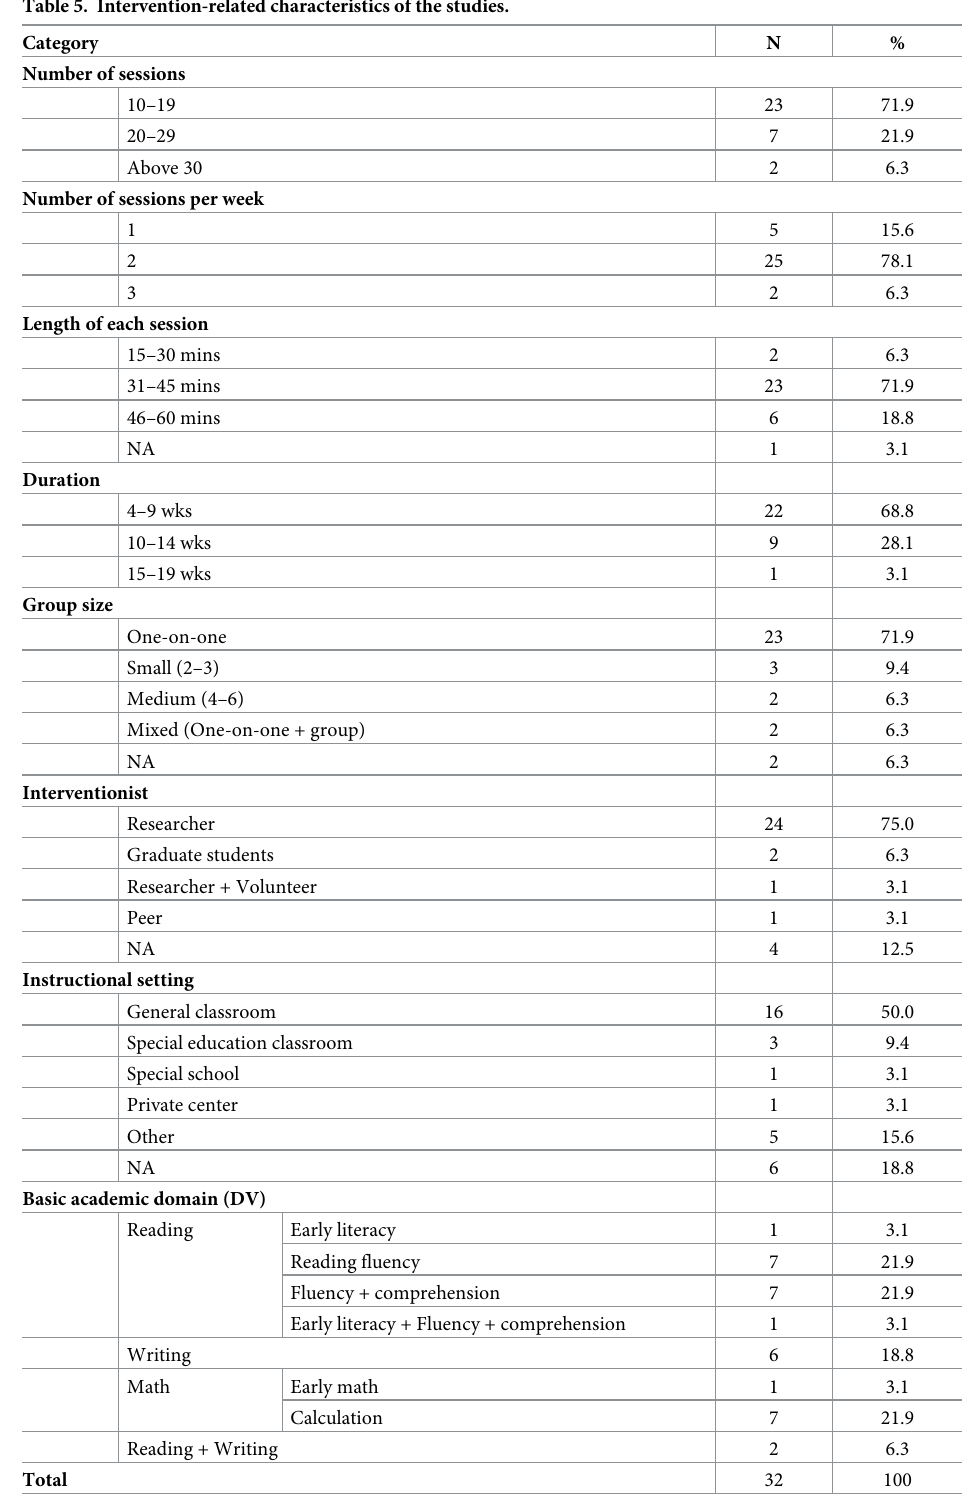
Table 5. Intervention-related characteristics of the